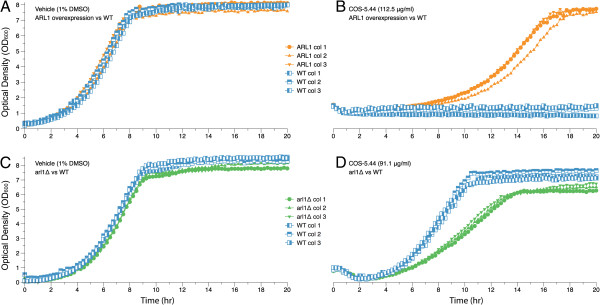
Confirmation of COS-5.44 resistance in the Arl1 overexpressing strain and sensitivity of the corresponding heterozygous deletion strain. The overexpression of ARL1 does confer resistance to COS-5.44 (112.5 μg/ml) compared with the wild type (vector control) that is not able to grow at this concentration. The heterozygous deletions strain (arl1Δ) shows sensitivity to COS-5.44 (91.1 μg/ml). A) Growth curves of ARL1 and wild type (vector control) growth in the vehicle. B) Growth curves of Arl1 overexpressing and wild type strains growth with COS-5.44 (112.5 μg/ml). C) Growth curves of the heterozygous deletion (arl1Δ) and wild type strain grown with the vehicle. D) Growth curves of heterozygous deletion (arl1Δ) and wild type strains grown with COS-5.44 (91.1 μg/ml). Optical density readings were taken every 15 min over 20 hrs using a Tecan Genios reader. Tecan ODs were converted to conventional 1 mm path length cuvette ODs using a calibration function provided by Ericson et al. 2010, [24]. Similar behaviour was observed for the rest of the selected overexpressing strains (Bck2, Erg24, Msg5 and Rba50) deduced to be resistant to chitosan oligosaccharide COS-5.44 from the MSP screen. The heterozygous deletion strains from these genes (bck2Δ, erg24Δ, msg5Δ and rba50Δ) were also individually tested for sensitivity to COS-5.44 (91.1 μg/ml). Three colonies of each strain were grown in triplicate and compared with the wild type in the presence of the COS-5.44 and the vehicle (1% DMSO).